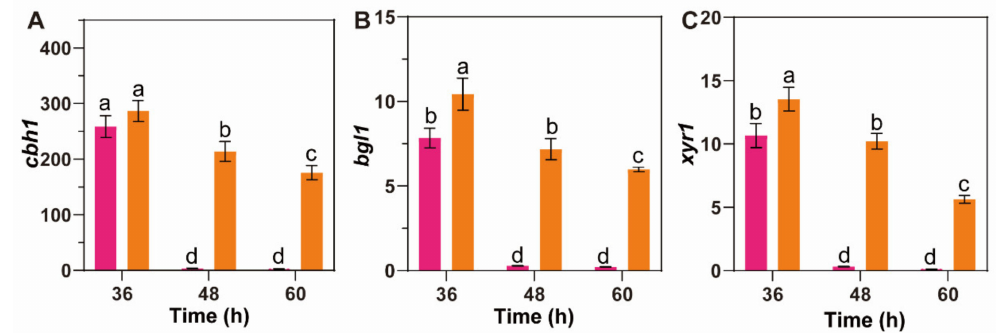
Figure 7. Effect of miglitol on the transcription of genes encoding cellulase (( A ) cbh1 ; ( B ) bgl1 ); and transcription factor (( C ) xyr1 ) at 36 h, 48 h and 60 h of T. reesei Rut C30 with 10 g/L MGD as the carbon source at 36 h, 48 h and 60 h. Values are the mean ± SD of the results from three independent experiments. One-way ANOVA was performed to reveal significant ( p < 0.05) differences between the mean values, which are indicated by different